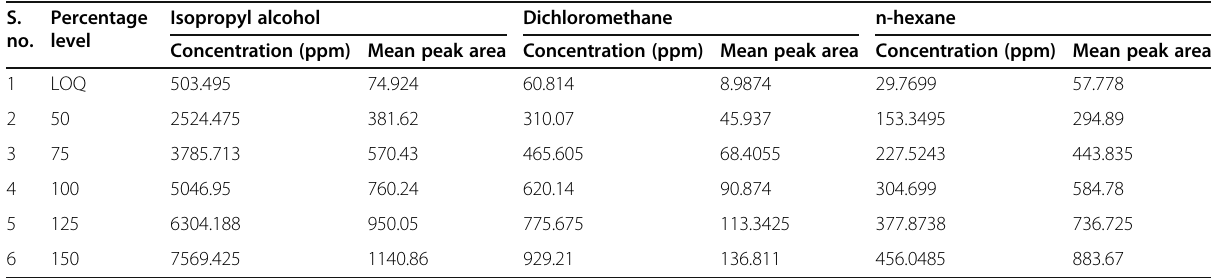
Table 6 Linearity and range of solvents S. Percentage no.